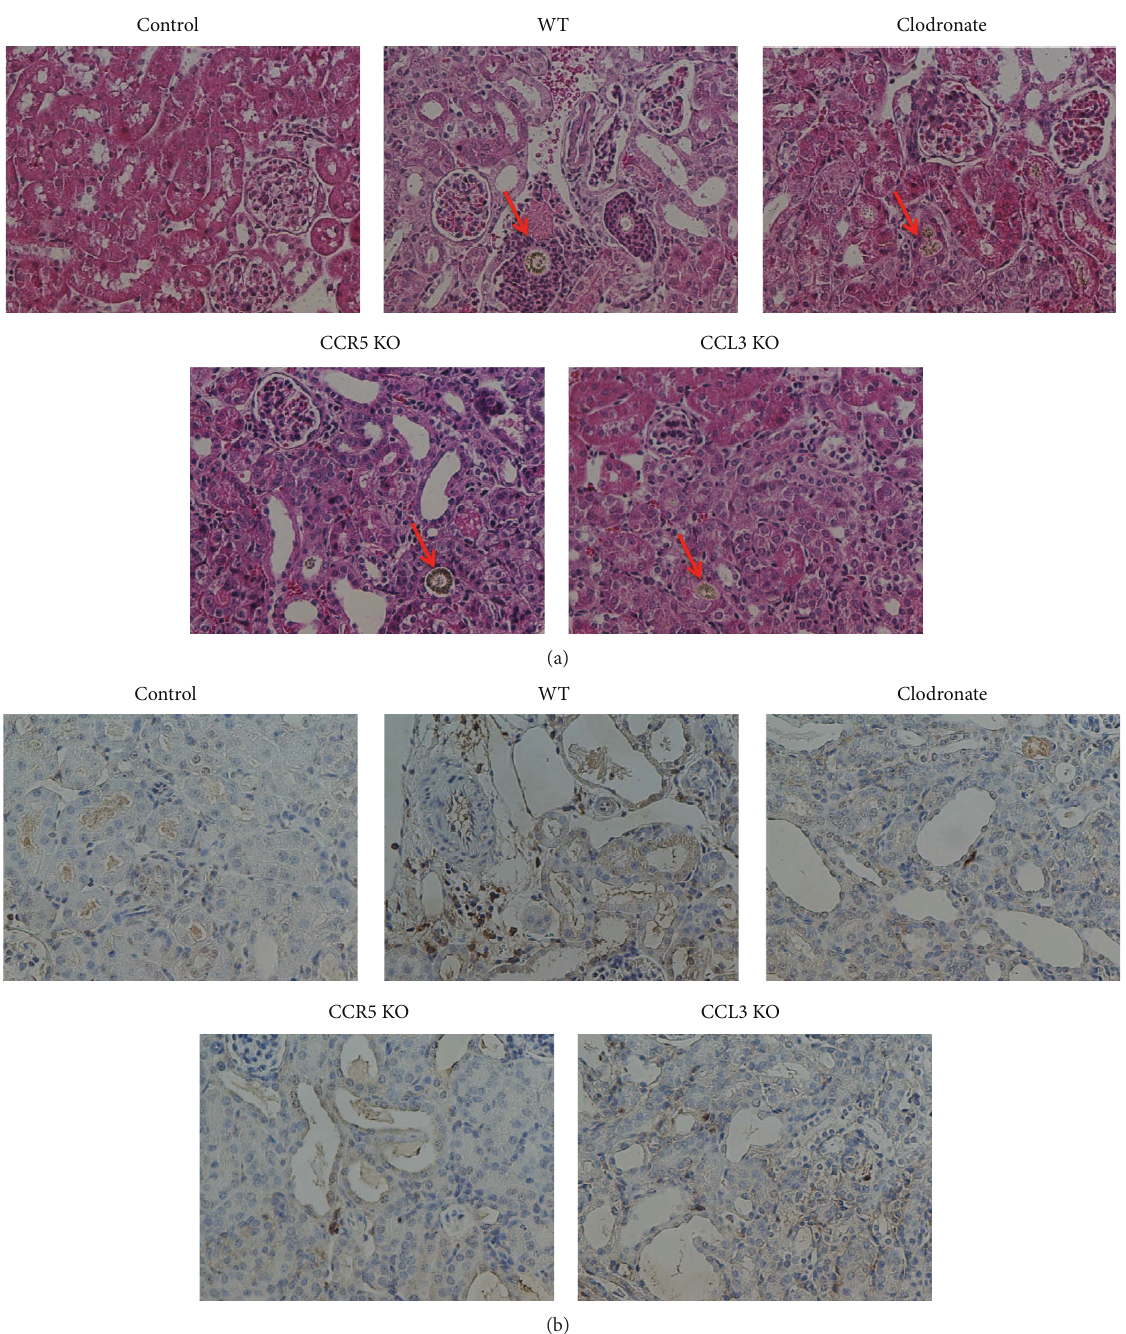
Figure 2: DHA crystals and macrophage localization after excessive adenine intake in WT, clodronate treated, CCR5, and CCL3 KO animals. (a) HE staining of the groups mentioned before showing the DHA crystals deposition in renal tissue, indicated by red arrows. In panel (b), IHC for CD11b is represented, showing macrophage infiltration in the different